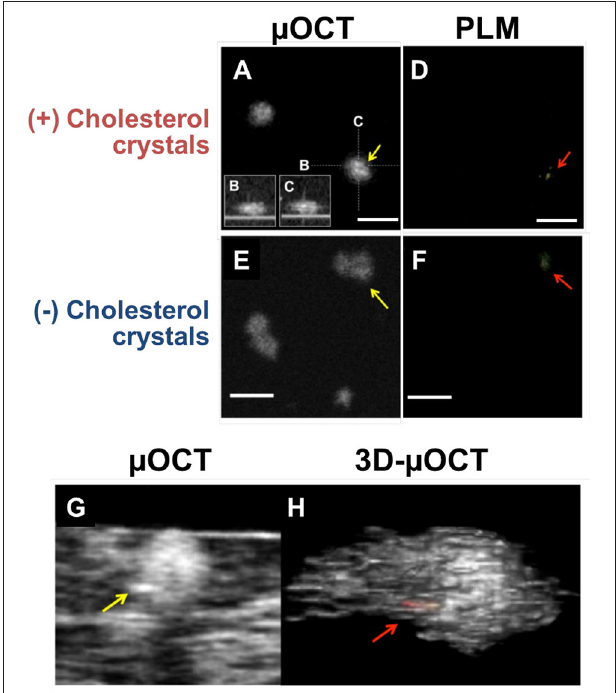
FIGURE 4 | µ OCT for macrophages containing cholesterol crystals in vitro and ex vivo. (A) En-face and (B,C) cross-sections of the macrophage demonstrated highly scattering constituents inside its cytoplasm (yellow arrow). (D) Corresponding polarization microscopy (PLM) confirming the cholesterol crystal inclusions (red arrow). (E) Cholesterol crystals that was determined by PLM (F) was not definitive on the µ OCT image (yellow arrow). (G,H) Representative µ OCT images of the macrophage cell in human coronary artery ex vivo contained highly scattering cholesterol inclusions within their cytoplasm [yellow arrow in panel (G) ; red in panel (H) ]. Scale bars, 50 µ m. Figure and capture reprinted with permission from Kashiwagi et al. (52).